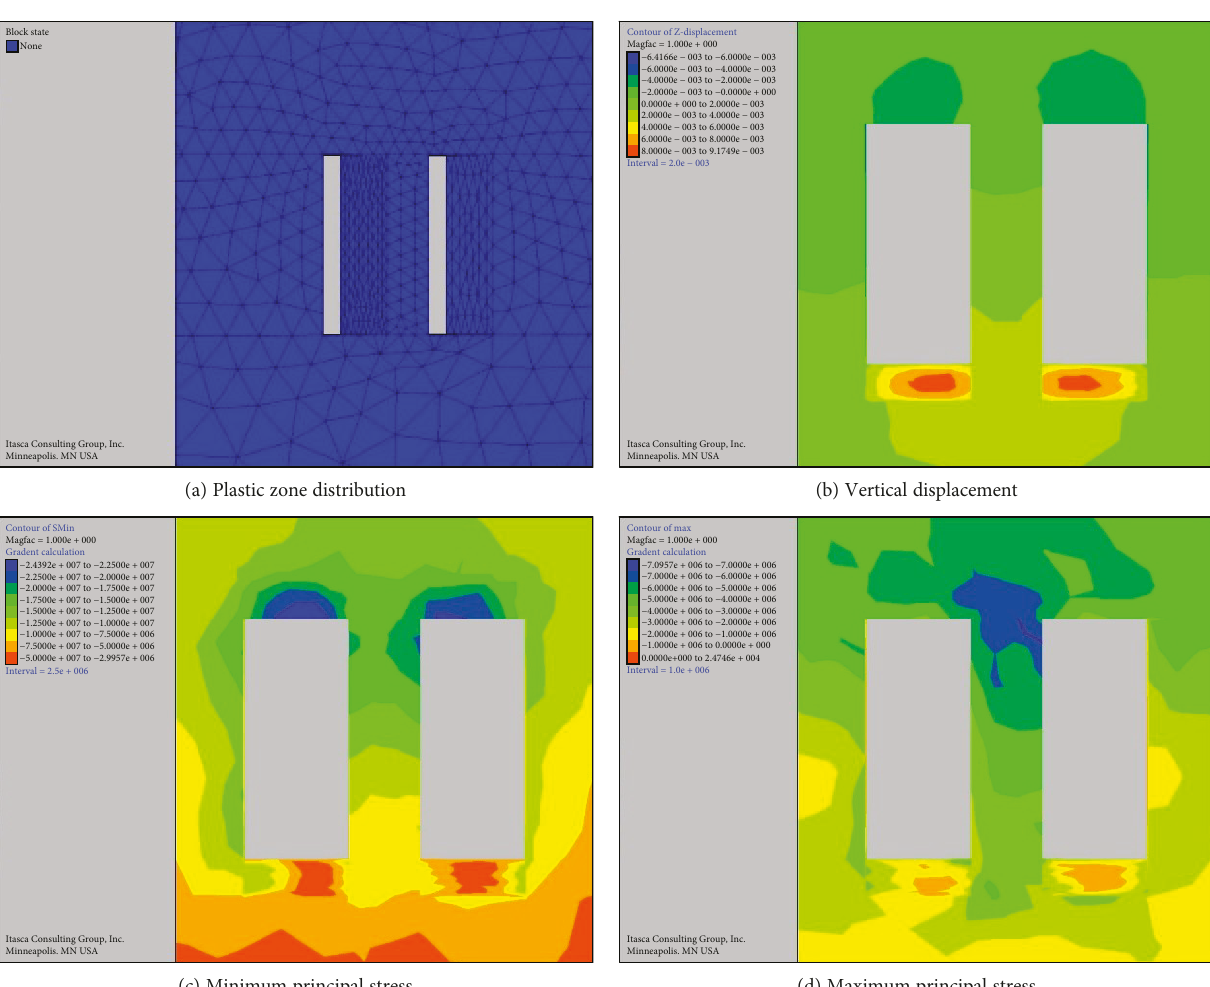
Figure 15: Scheme 3 mining